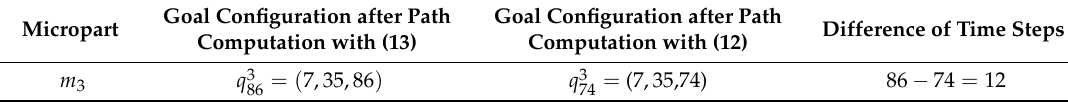
Table 5. Start and goal configurations of the third micropart, comparing functions (11) and (12).